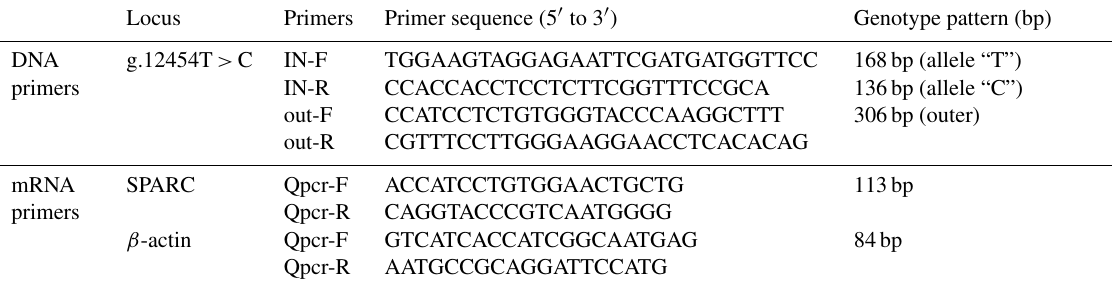
Table 1. Primer information. Locus Primers Primer sequence (5 (cid:48) to 3 (cid:48)